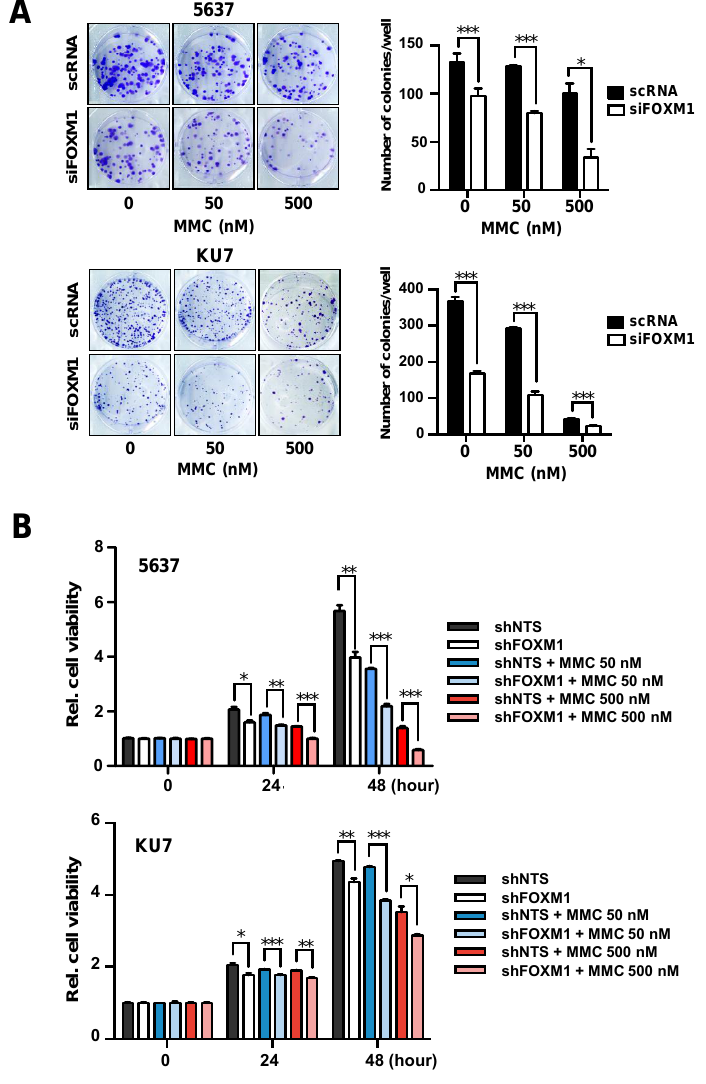
Figure 3. Analysis of MMC resistance following suppression of FOXM1 expression. ( A ) siRNA (scRNA or siFOXM1)-transfected 5637 and KU7 cells exposed to the indicated concentrations of MMC for 24 hours and seeded at 500 cells / well. After 10 days, colonies were stained with crystal violet and counted using a microscope. ( B ) The survival rate of 5637 and KU7 cells stably expressing shNTS or shFOXM1 was measured by MTT assay after exposure to the indicated concentrations of MMC (Mitomycin C) at the indicated times. (*, p < 0.05; **, p < 0.01; and *** p <